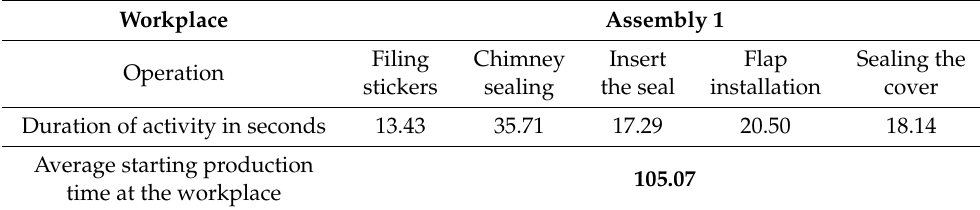
Table 4. Average initial production time (seconds) at the workplace Assembly